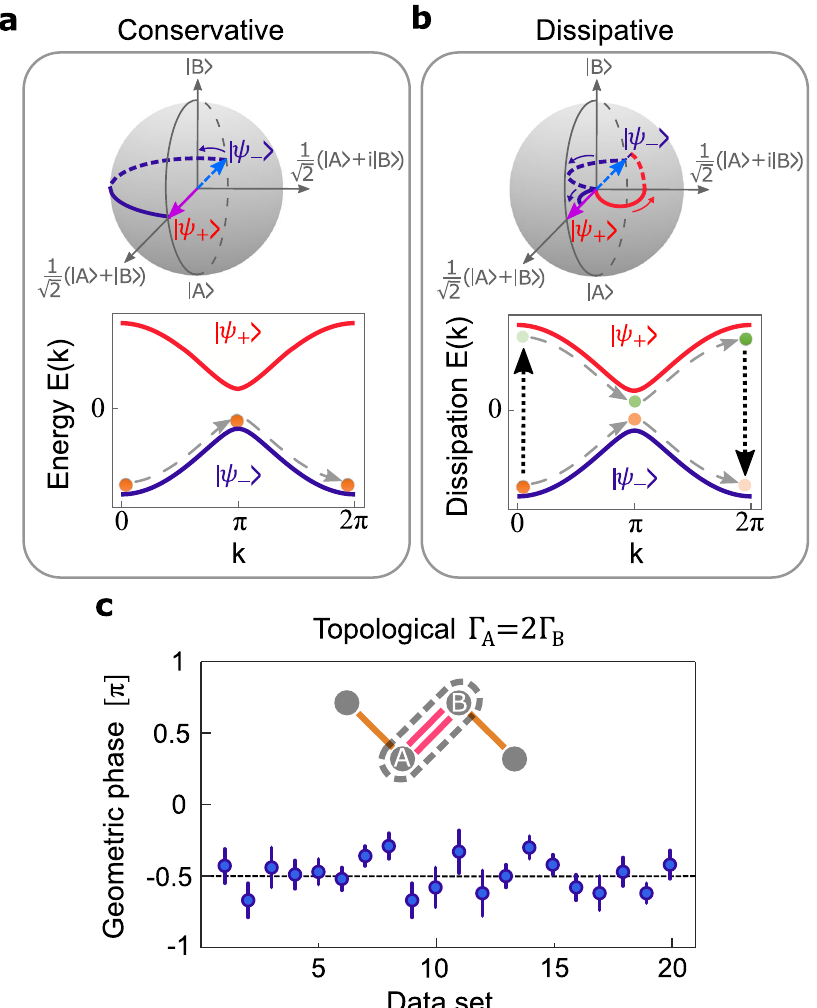
Fig. 4 | Modi fi ed geometric phases in the presence of non-Abelian effects. a Geometric winding of the lower-band Bloch eigenstates associated with a con- servative SSH Hamiltonian illustrated on the Bloch sphere. In this representation, theupperandlowerBlocheigenstatesarelocatedontheequatorialplane,shownin red and blue colors, respectively. Here, ∣ A i and ∣ B i represent the uniformly dis- tributed states residing on the A and B sublattices, corresponding to the points located on the south and the north poles of the Bloch sphere, respectively. The magenta and light blue arrows represent the upper- and lower-band Bloch eigen- states associated with the Bloch momentum k =0, respectively. The lower panel indicates reciprocal-space dynamics associated with the lower band, which in the adiabatic regime is independent of the upper band. b Similar results for a dis- sipativeSSHLindbladianareobtainedfromthecorrespondingmodi fi edWilsonline operator (Eq. (2)). Unlike the conservative case a , the lower-band of a dissipative SSHlatticeisexpectedtoexhibitadifferentgeometricphasethanthatoftheupper